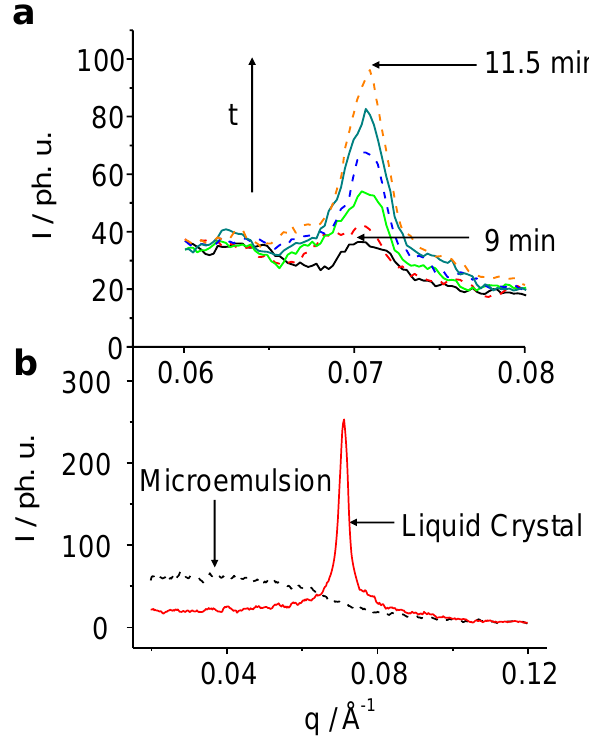
E system after the 633 nm irradiation. ( a ): 8 4